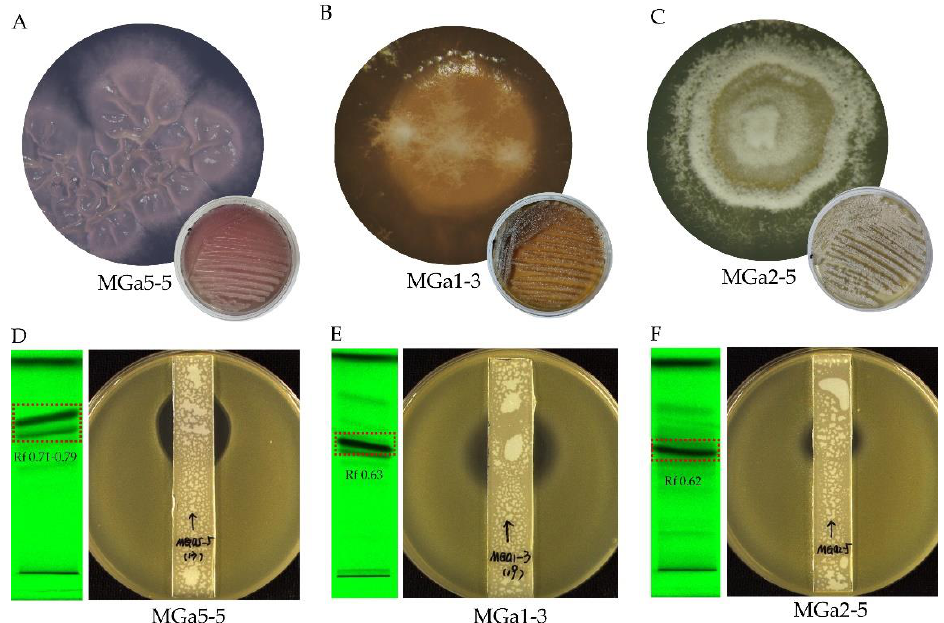
Figure 5. Colony morphology of Streptomyces isolates MGa5-5 ( A ), MGa1-3 ( B ) and MGa2-5 ( C ), and TLC analysis of the EA extracts from fermentation broth ( D – F ). Colony morphology was photographed after growing on ISP2 media for about 7 days. TLC analysis was coupled with anti-MRSA assay, and TLC bands was visualized at 254 nm.